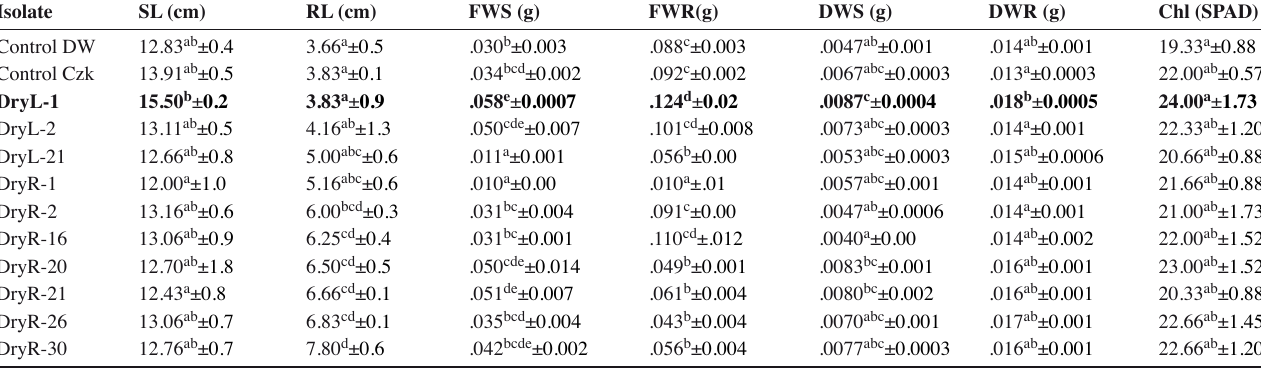
Tab. 1: Influence of A. violaceofuscus CF on the growth features of rice plants. The isolate DryL-1 marked in bold was chosen for further analysis.